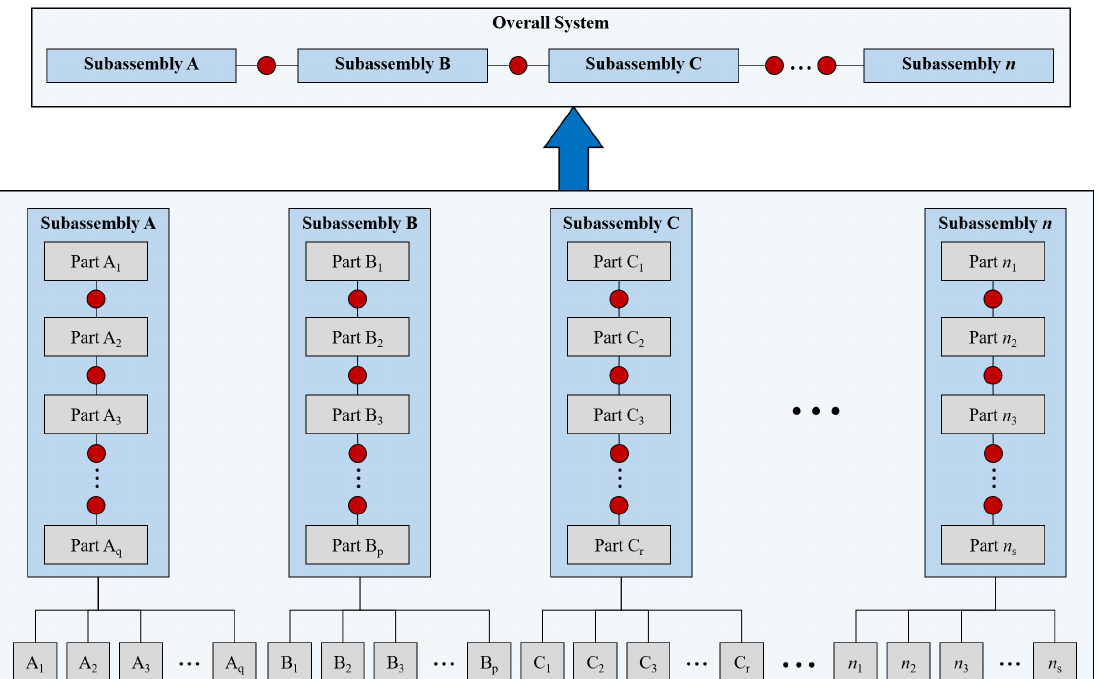
Figure 4. Modular design complexity levels (adapted from